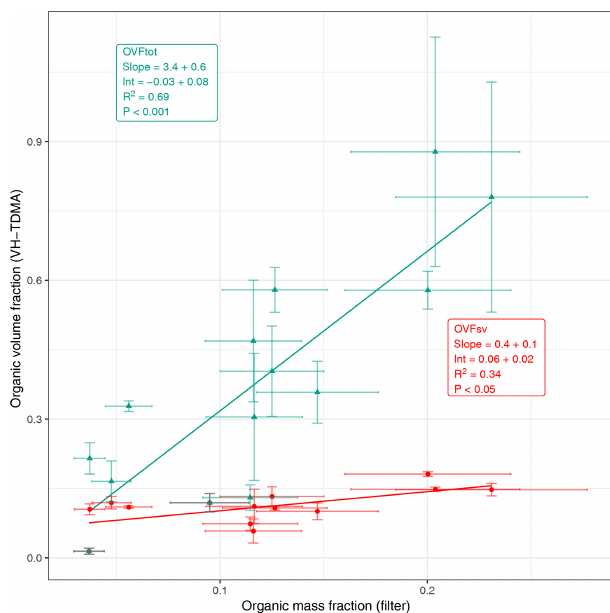
Figure 6. Comparison of the 50nm organic volume fraction calcu- lated from volatility measurements (using VH-TDMA) and the PM 1 OMF measured using FTIR/IBA on filter samples. Volatile fractions are shown in red; total organic fractions are shown in